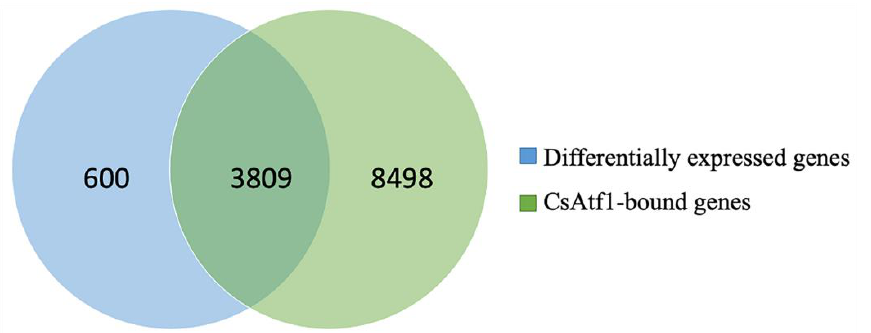
Figure 2. Venn diagram of significantly differentially expressed genes in the ∆ CsAtf1 mutant and genes bound directly by the transcription factor CsAtf1.